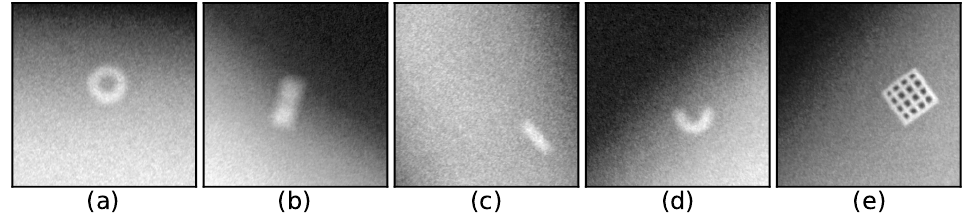
Figure 4. Examples of synthetic defect and anomaly indications inserted into weld okay patches: ( a ) circular hollow inclusion, ( b ) dogbone inclusion, ( c ) elongated inclusion, ( d ) partial circle inclusion, and ( e )